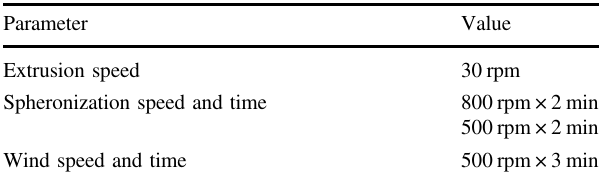
Table 6 The effect of the weight gain of enteric layer on release behavior of aspirin enteric-coated pellets in 0.1 mol/l HCl solution The weight gain (%)